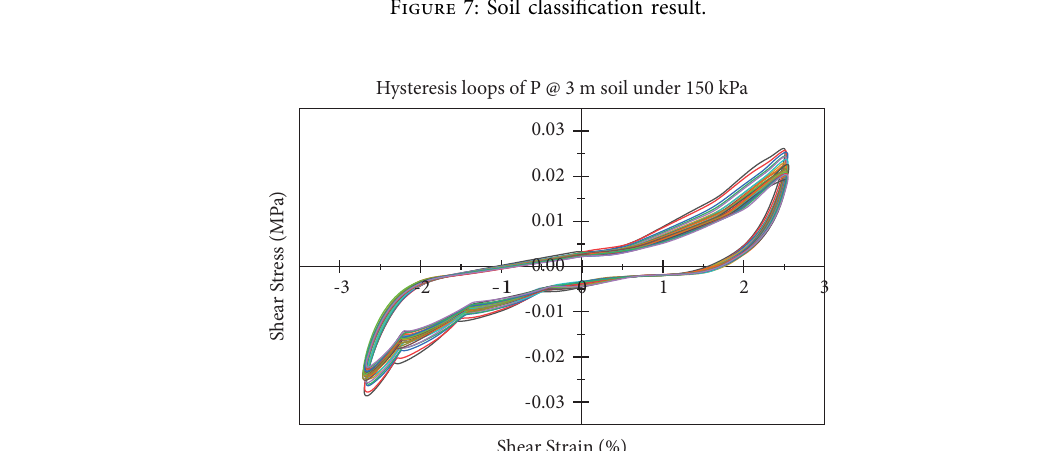
Figure 7: Soil classifcation result.